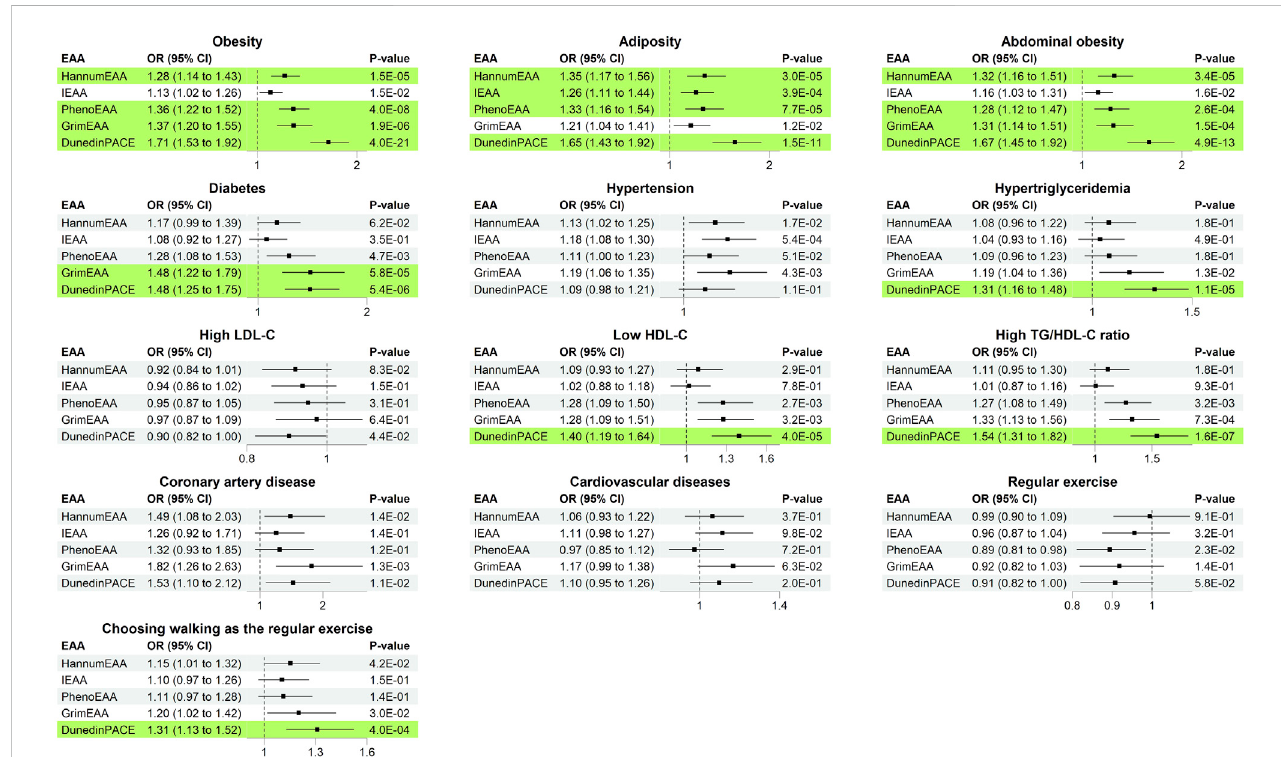
FIGURE 3 Odds ratio (with 95% C.I. and p -values) of increasing one standard deviation of epigenetic age acceleration. Signi fi cant results with p < 0.05/(25 × 5) = 4.0E-4 were marked in green